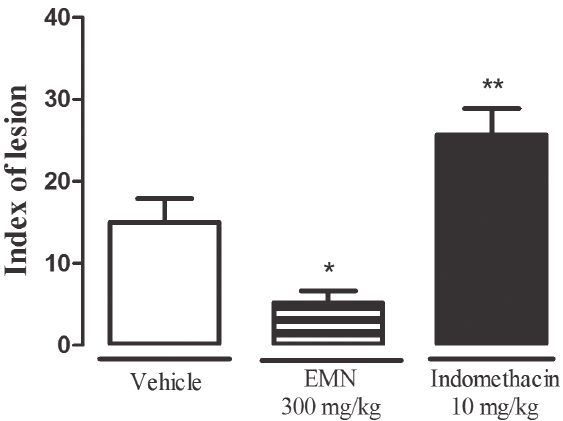
Figure 1 - Effect of ethanolic root extract of Memora nodosa (EMN) on food restriction induced gastric ulcer. Results were expressed as Mean ± SEM. n = 9. Data were analyzed by ANOVA followed by Newman-Keuls test. *p < 0.05; **p < 0.01 compared with control group (Vehicle). e ffect of tHe EMN on g aStric J uice P arameterS